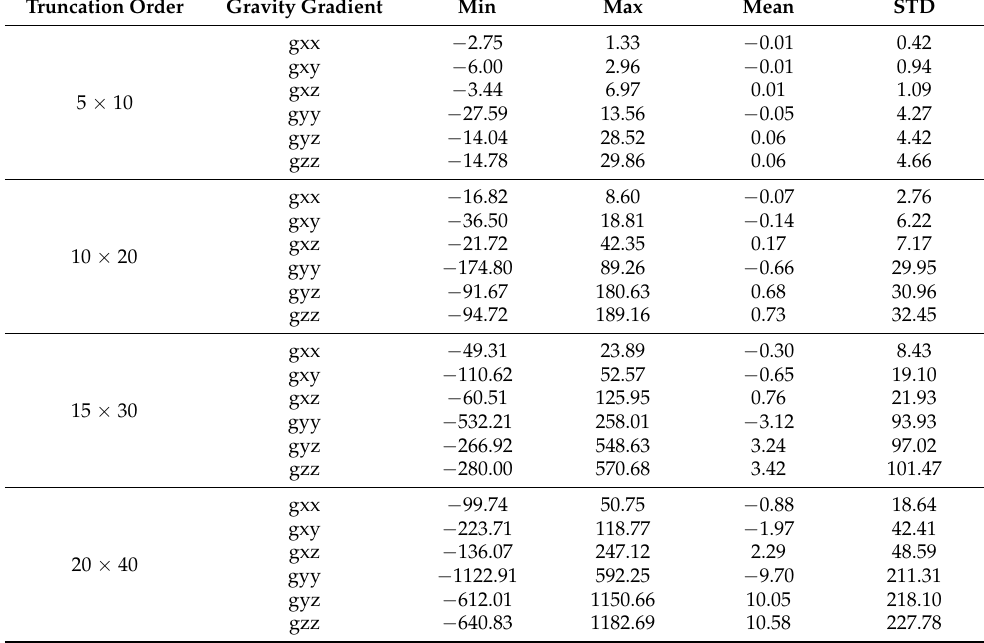
Table 4. Statistical table of experimental results from the Qinghai–Tibetan Plateau. Unit: E